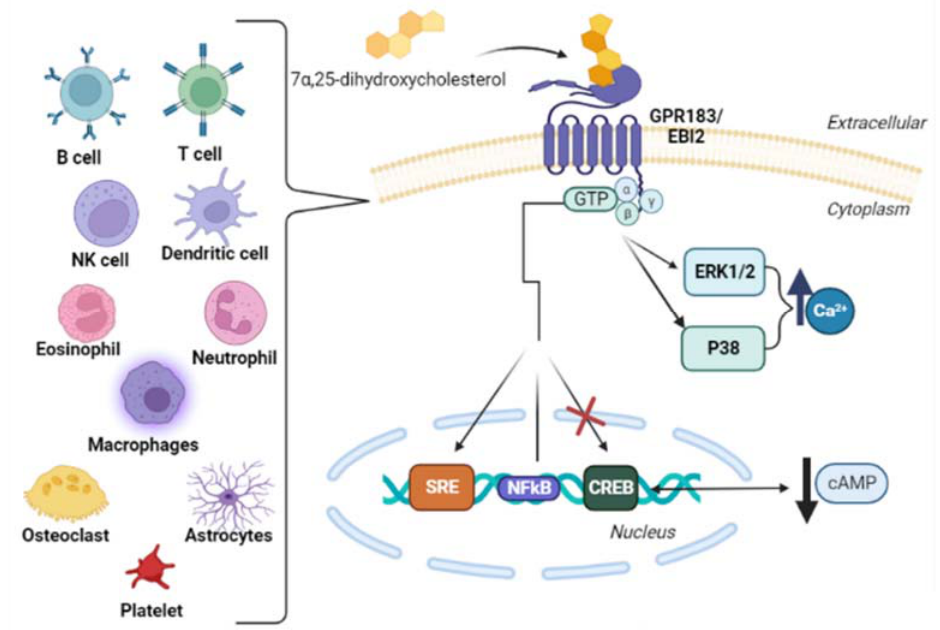
Figure 3. Schematic pathway of EBI2 receptor activation in cells that express this receptor. 7 α ,25- dihydroxycholesterol, a ligand of EBI2 (Epstein–Barr-virus-induced molecule-2), activates the GTPases family and mitogen-activated protein kinases/extracellular signal-regulated kinase (ERK) and P38 to intracellular calcium flux. In the nucleus, GTPases stimulate the expression of SRE (Serum Response Element) and the expression of NF κ B (nuclear factor kappa-light-chain-enhancer of activated B cells) (weak stimulation), and inhibit the expression of CREB (cAMP Response Element-Binding Protein), downregulating the production of cAMP (cyclic Adenosine Monophosphate) [53,61].